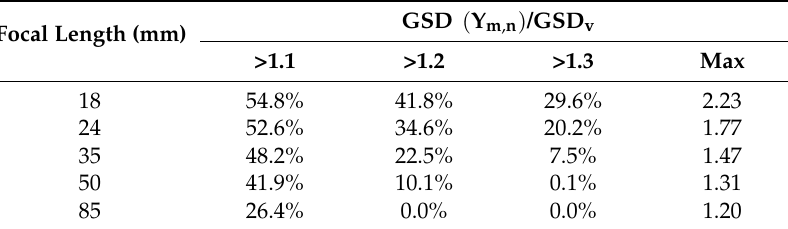
Table 3. Relationship between focal length and distribution of